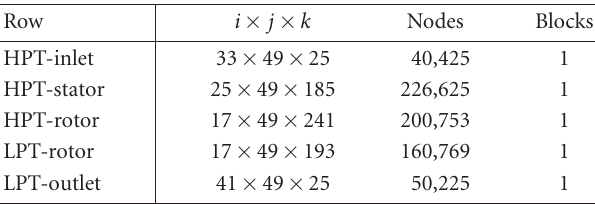
Table 1: Grid dimensions ( i -azimuthal direction, j -spanwise direc- tion, k -streamwise